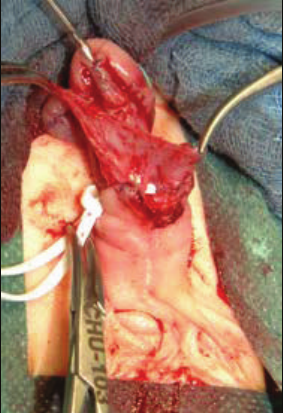
Figure 2: Incised and tubularised urethral plate with the ventrally transpositioned dartos